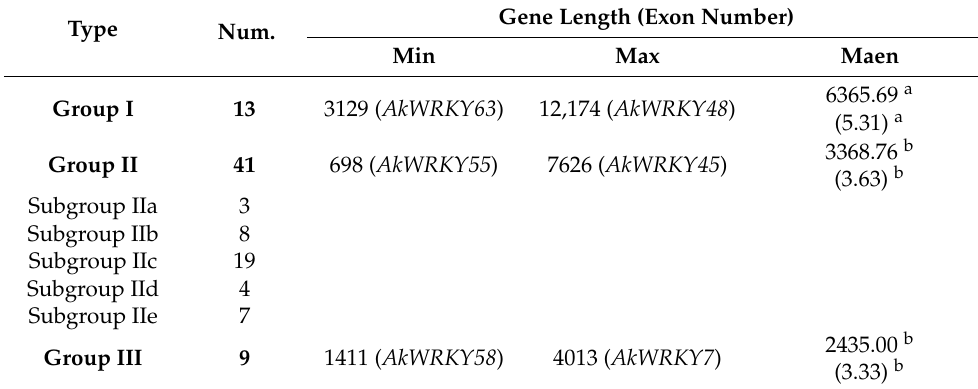
Table 1. Groups of WRKY genes in the A. trifoliata